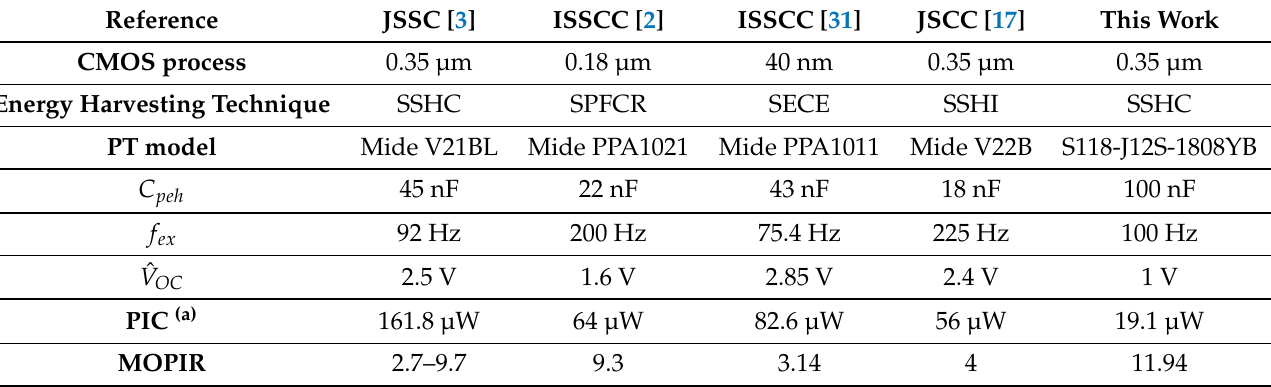
Table 2. FAR performance compared to the state-of-the-art